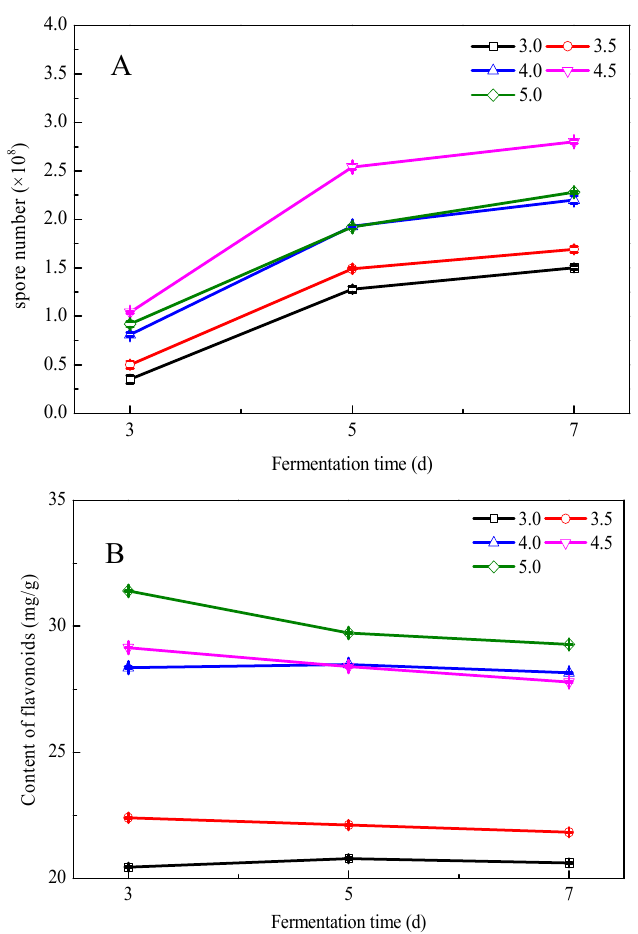
ff ects of pH on di ff erent indexes: ( A ) spore number and ( B ) flavonoid Figure 3. Effects of pH on different indexes: ( A ) spore number and ( B ) flavonoid content. Figure 3. E